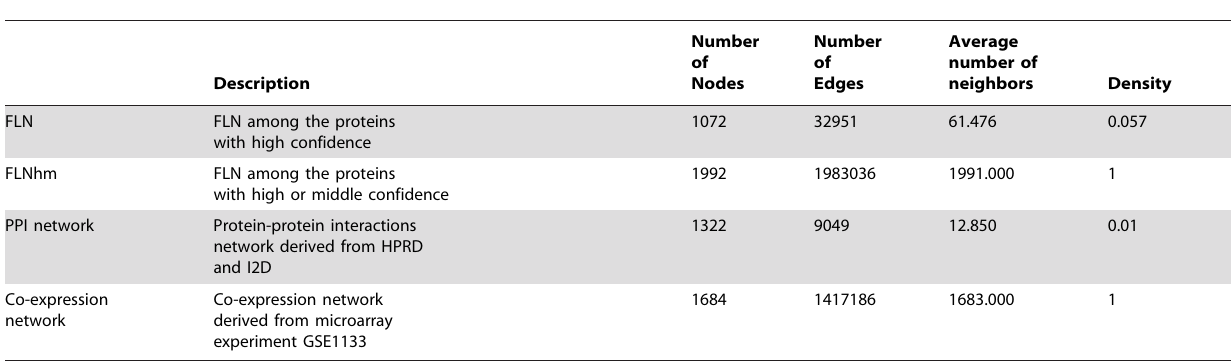
Table 4. Descriptions and parameters of four